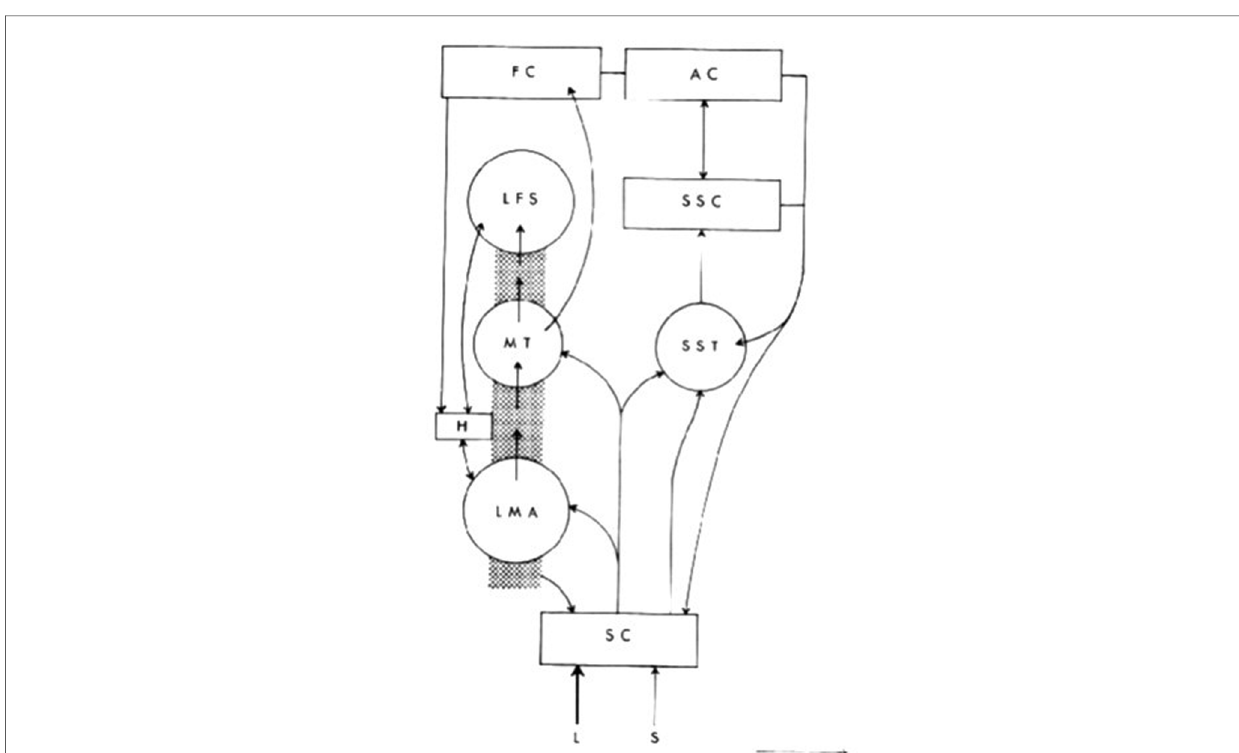
FIGURE 2 ORIGINAL FIGURE 20.4 (WITH